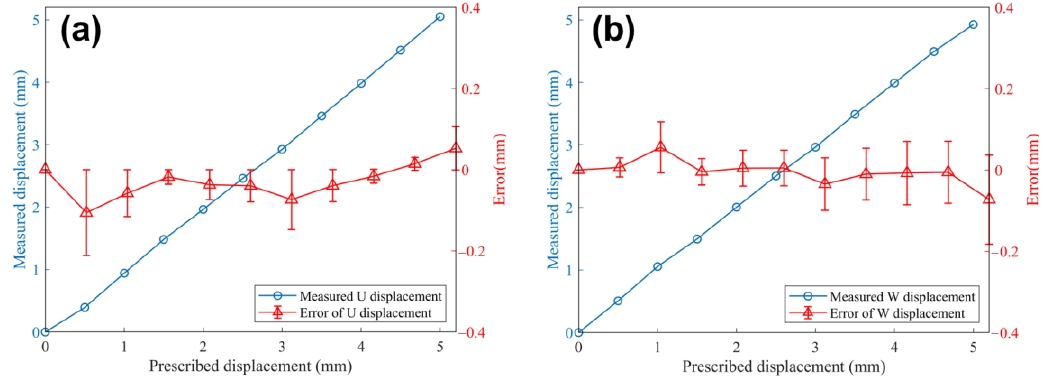
Figure 4. Experimental results of the ( a ) in-plane translation test and ( b ) out-of-plane translation test.